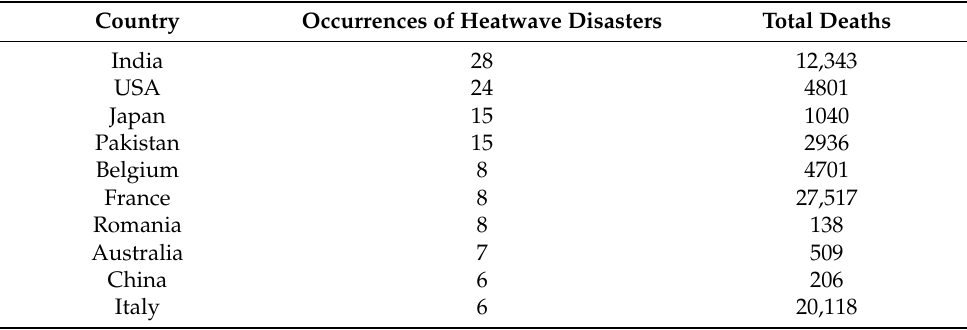
Table 1. Occurrences of heatwave disasters in the most affected countries over the globe from 1900 to 2021 as reported in the Emergency Events Database (EM-DAT). Country Occurrences of Heatwave